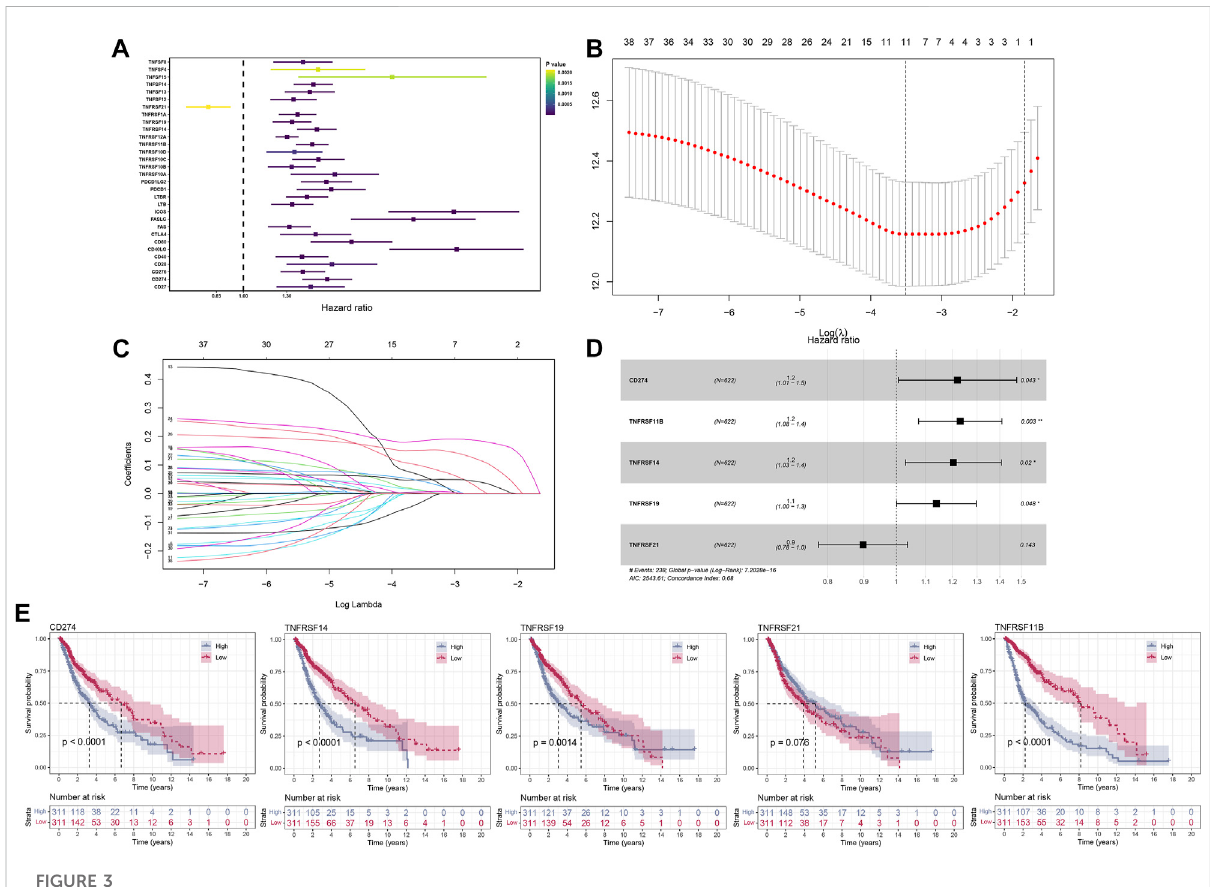
FIGURE 3 The construction of the model based on costimulatory molecules. (A) 31 costimulatory molecules, including 1 protective factor and 30 risk factors, were identi fi ed by univariate regression analysis. (B,C) LASSO regression analysis was performed on costimulatory molecules identi fi ed by univariate Cox regression analysis. (D) Multivariate Cox regression analysis identi fi ed fi ve costimulatory molecules for model construction. (E) KM survival curves analysis was performed on fi ve model costimulatory